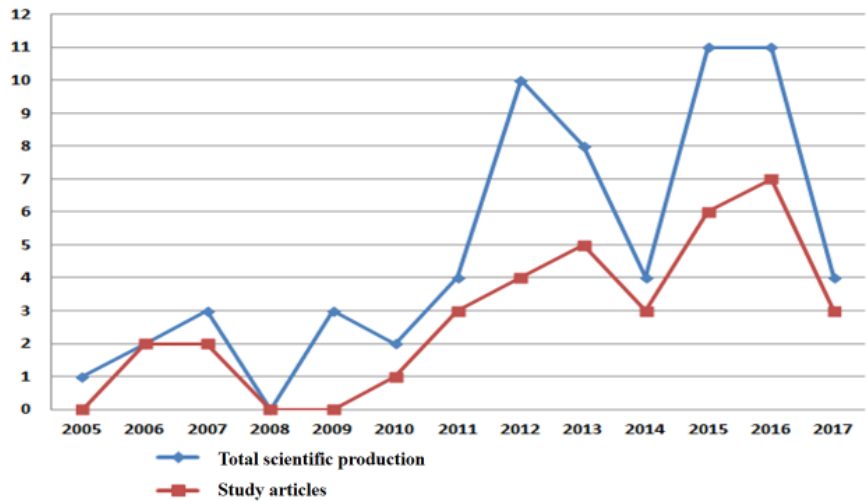
Figure 2. Evolution of the scientific production of the population and study sample.